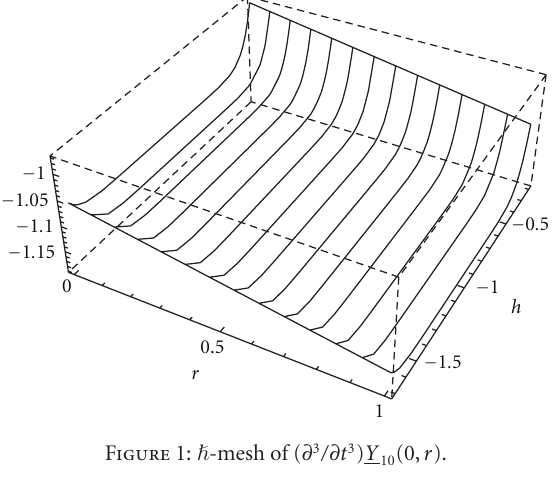
Figure 1: (cid:2) -mesh of ( ∂ 3 /∂t 3 ) Y